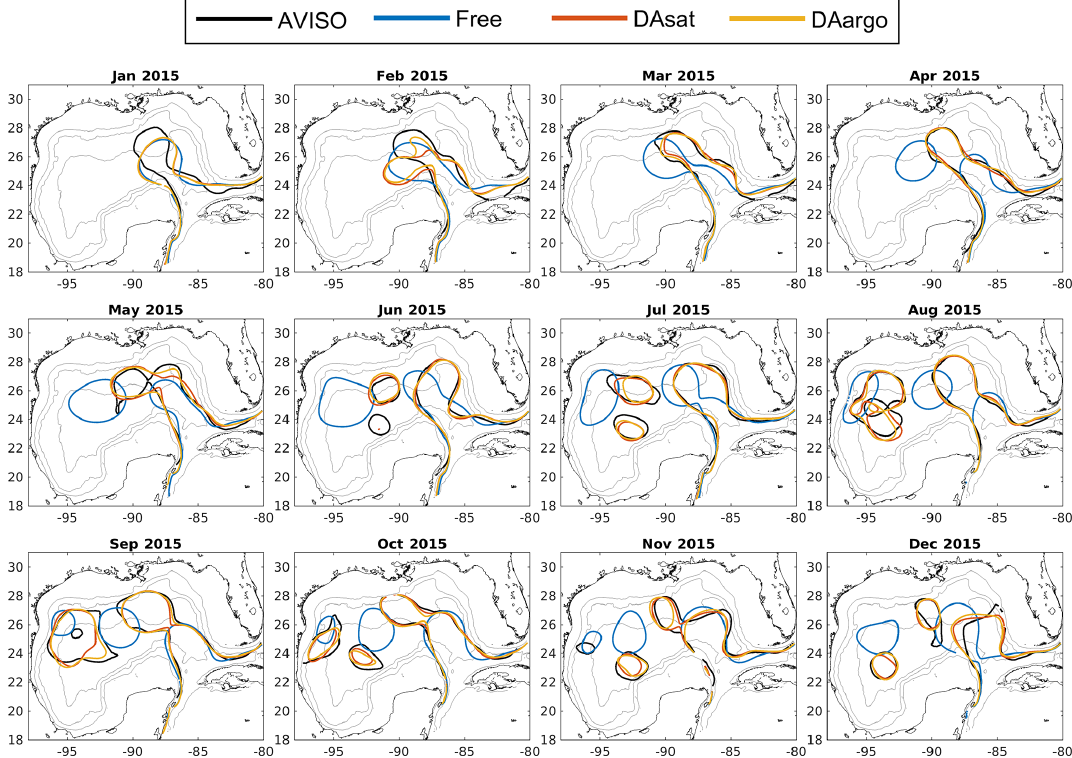
Figure 2. Monthly averaged Loop Current and Loop Current eddies based on the 10cm SSH contour from satellite data (black), the Free run (blue), the DAsat run (orange), and the DAargo run (yellow). The gray contours represent the isobaths of 200, 1000, and 3000m.